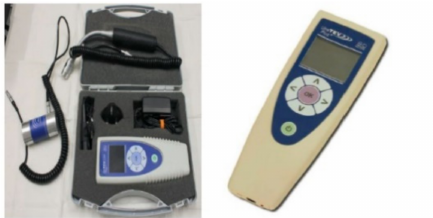
Figure 2. Airborne ultrasonic test